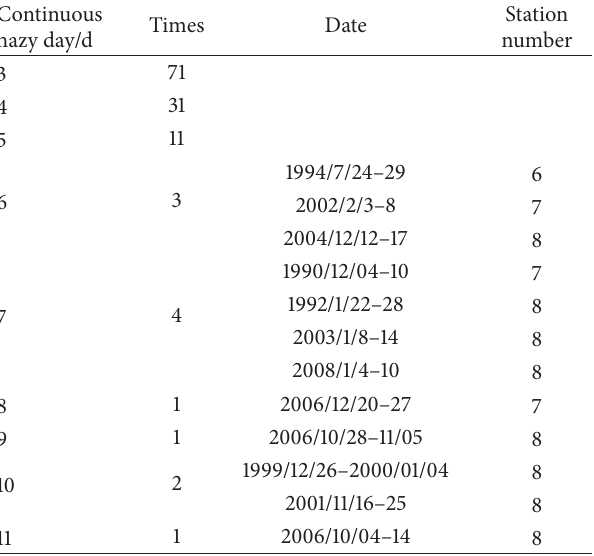
Table 4: Regional characteristics of continuous hazy